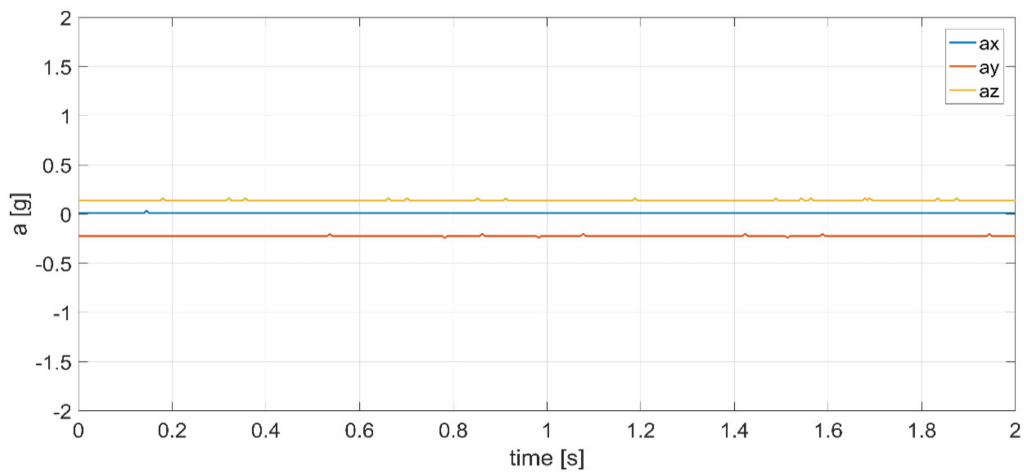
Figure 14. Plot of the experimentally measured accelerations when the device stands still.